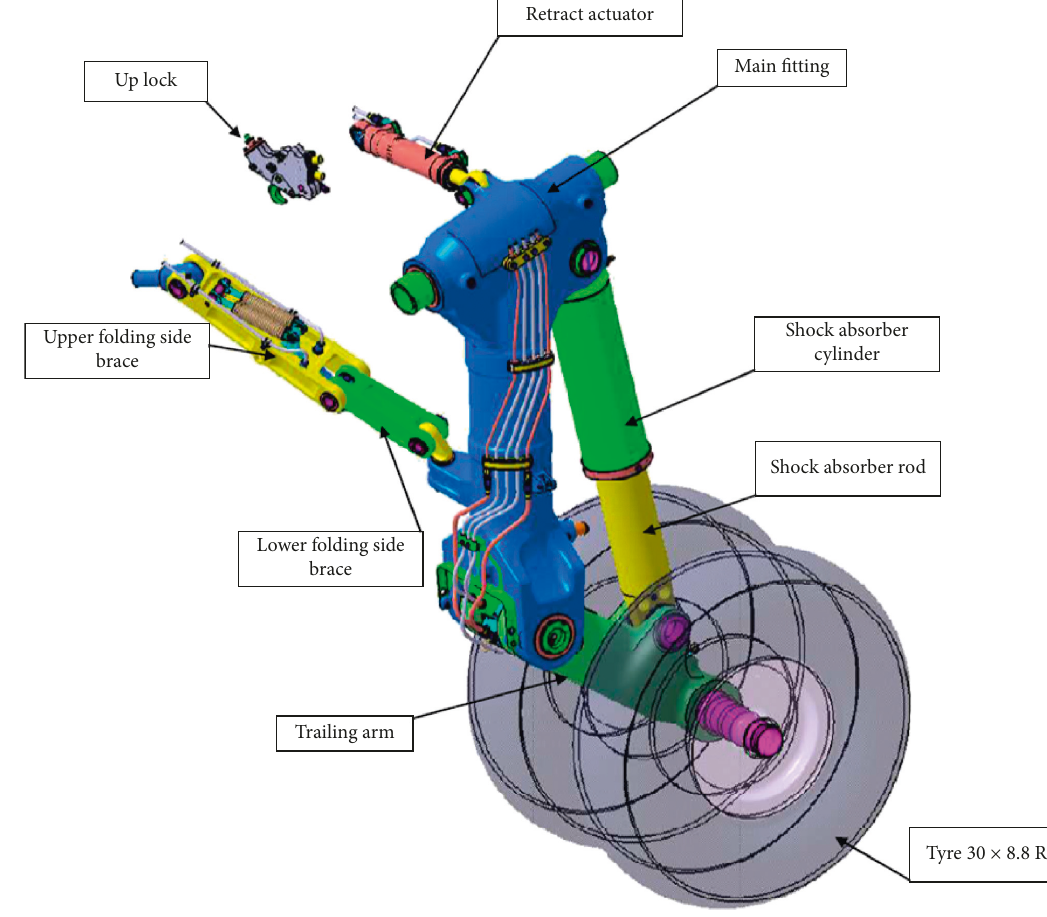
Figure 1: Main landing gear.